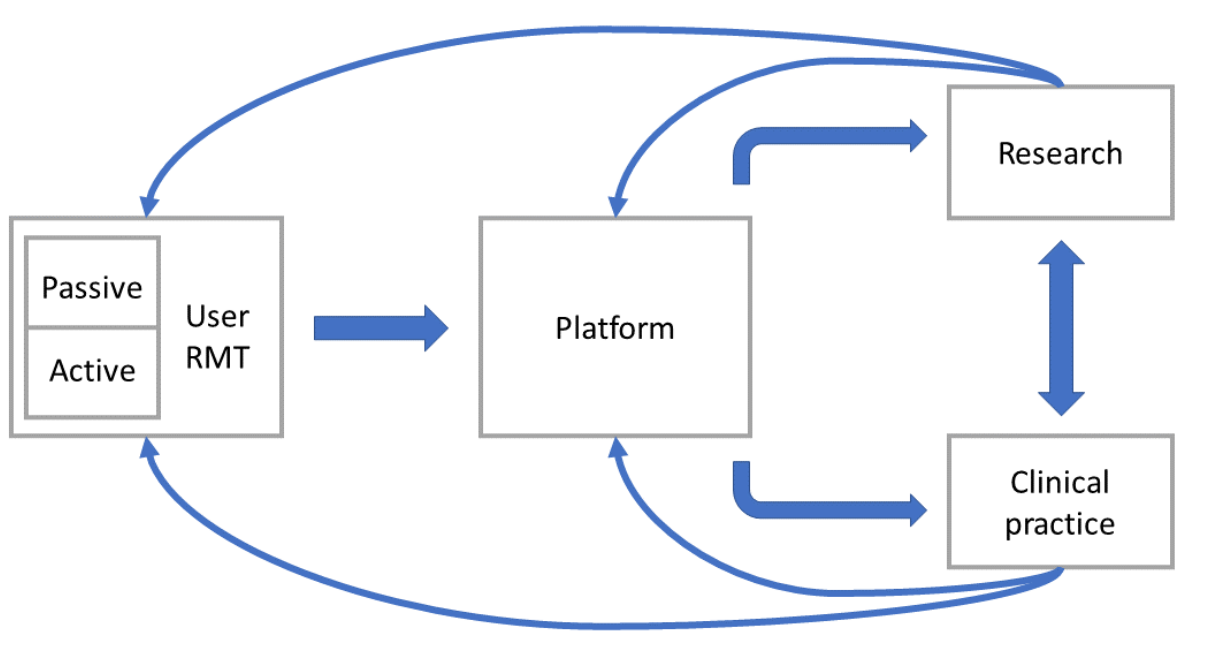
Figure 1. Diagram showing how the platform under development is intended for use in clinical practice and research. The platform is supplied with data from passive and active remote measurement technology worn or carried by patient users, as instructed by the clinic or in research protocols. Use in research and practice will inform further development of the platform. RMT: remote measurement